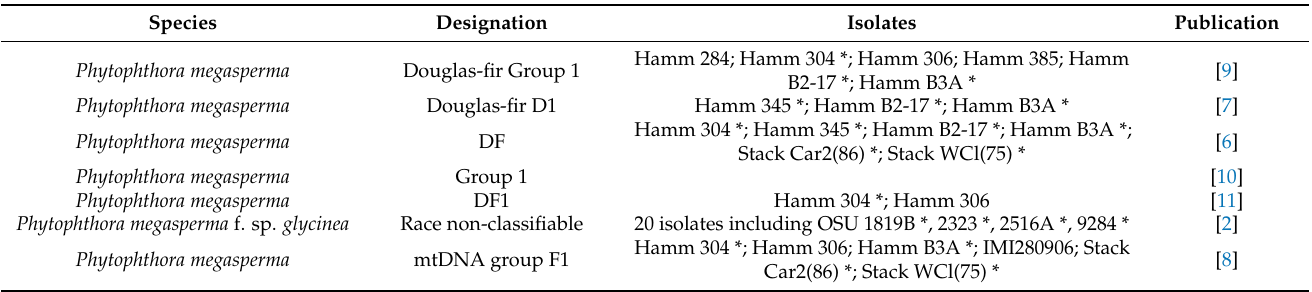
Table 1. Nomenclature and informal designations of Phytopthora sansomeana isolates prior to species description by Hansen et al.,